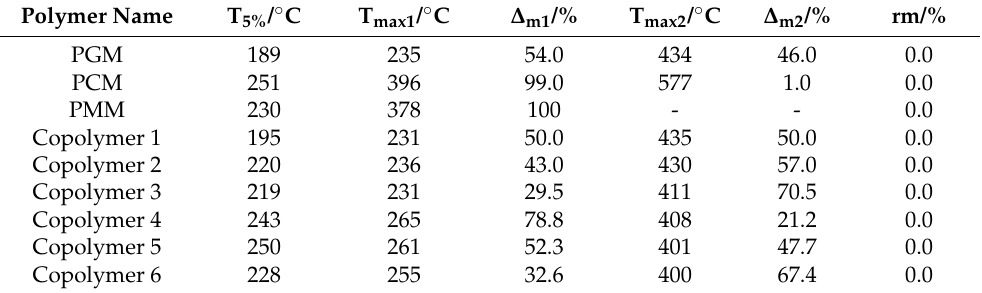
Table 10. TG/DTG data for the materials studied in helium (conditioned at 120 ◦ C—series